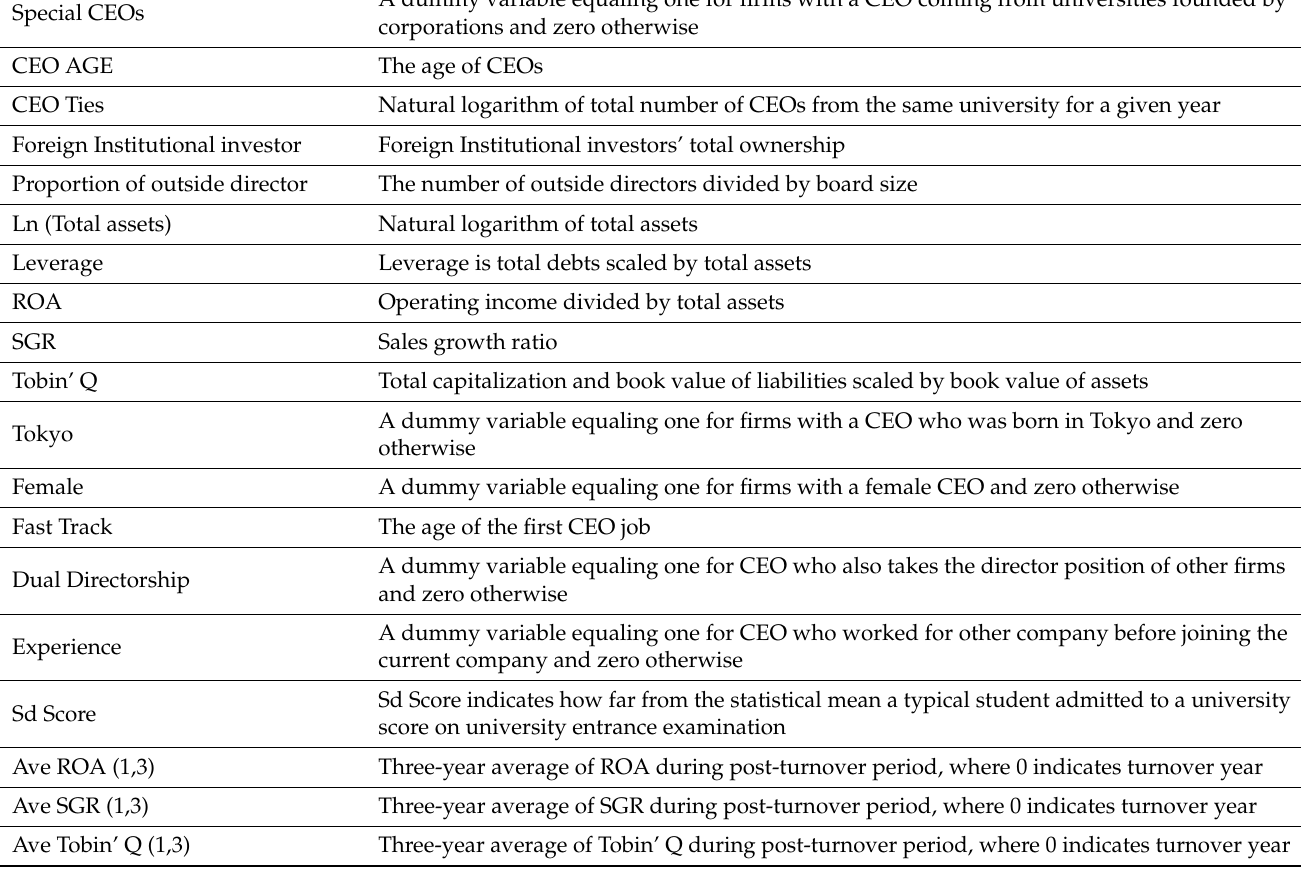
Table A1. Definitions of variables.